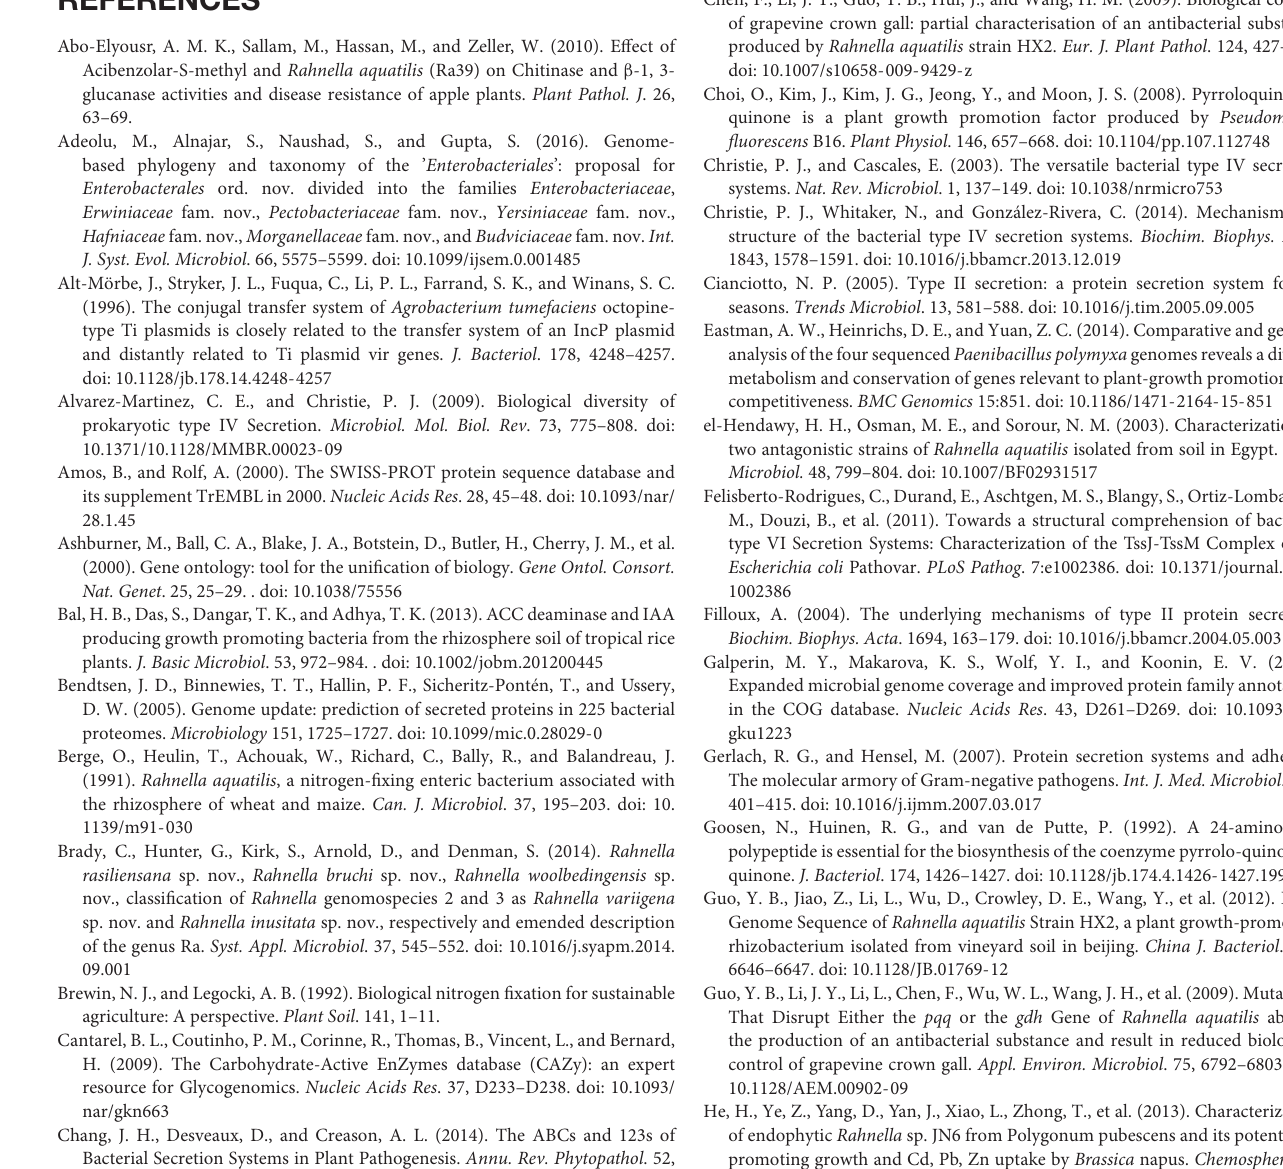
rpoB ) according to the aligned gene sequences using maximum likelihoods derived from MEGA 6.0 software. Bootstrap values (1,000 replicates) were shown at the branch points. The scale bar indicates 0.05 nucleotide substitutions per nucleotide position. Supplementary Figure 6 | Percentage of the average nucleotide identities (ANI) and in silico DNA-DNA hybridization (DDH) among the selected Rahnella strains. ANI values were computed for a pairwise genome comparison using the OrthoANIu algorithm. The percentage of ANI was shown on the top right . DDH values were calculated by using the Genome-to-Genome Distance Calculator (GGDC). The percentage of DDH was shown on the bottom left . Supplementary Figure 7 | Comparisons of Pyrroloquinoline Quinone genes of R. aceris ZF458 against four other previously fully sequenced Rahnella genomes. The same color represented genes with the same biological